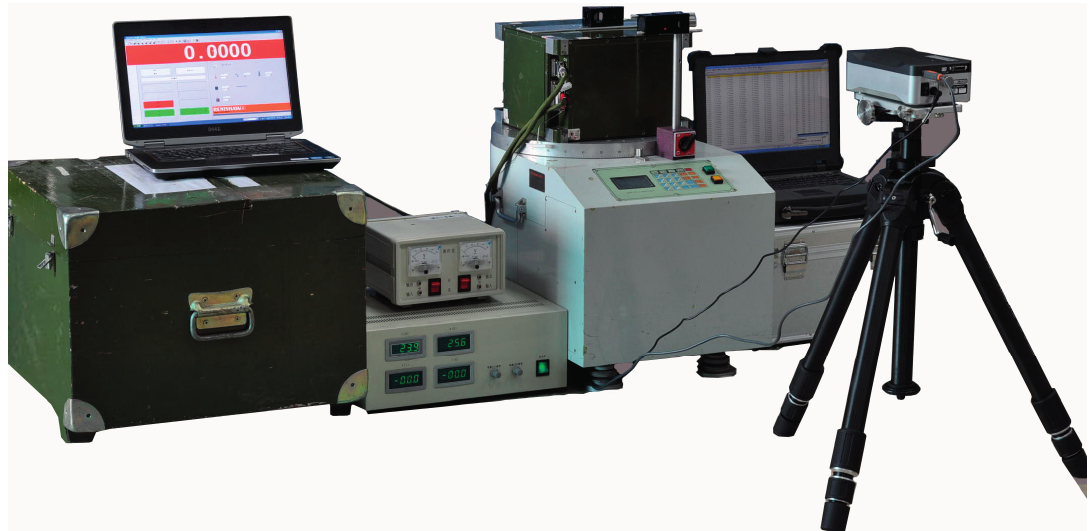
Figure 8. Synchronization mechanism verification equipment.